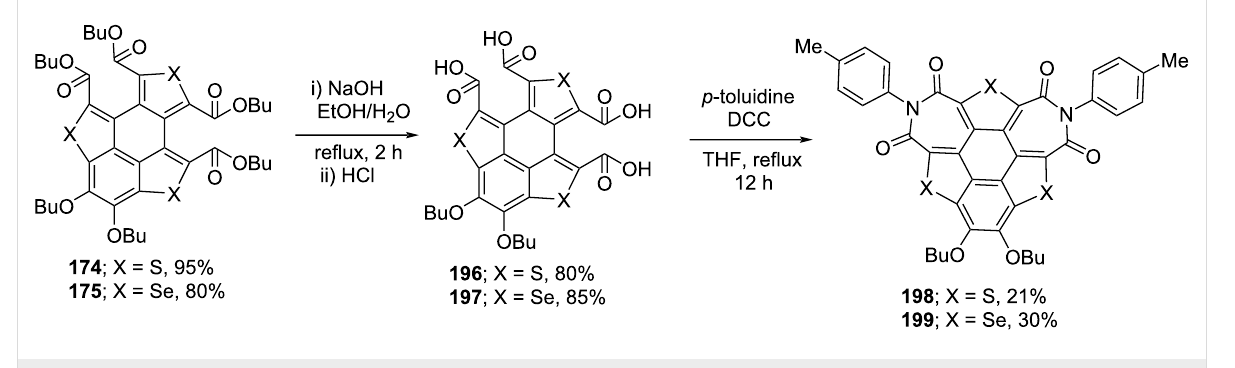
152 using bromine in CH 2 Cl 2 to produce two isomeric tri- bromotriphenylene derivatives 210 and 211 as depicted in Scheme 51. The doubly cyclized monobromo derivative